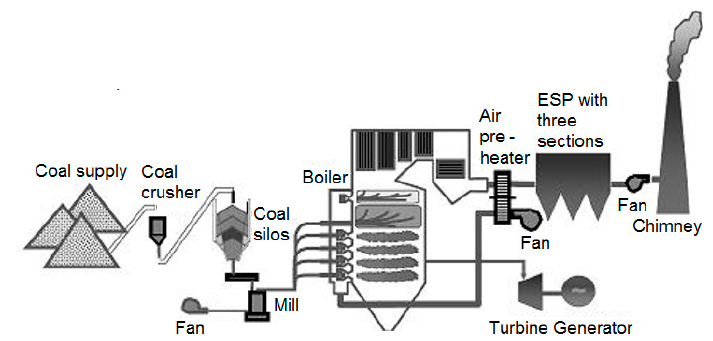
Figure 1. The thermal power plant’s typical design [8].